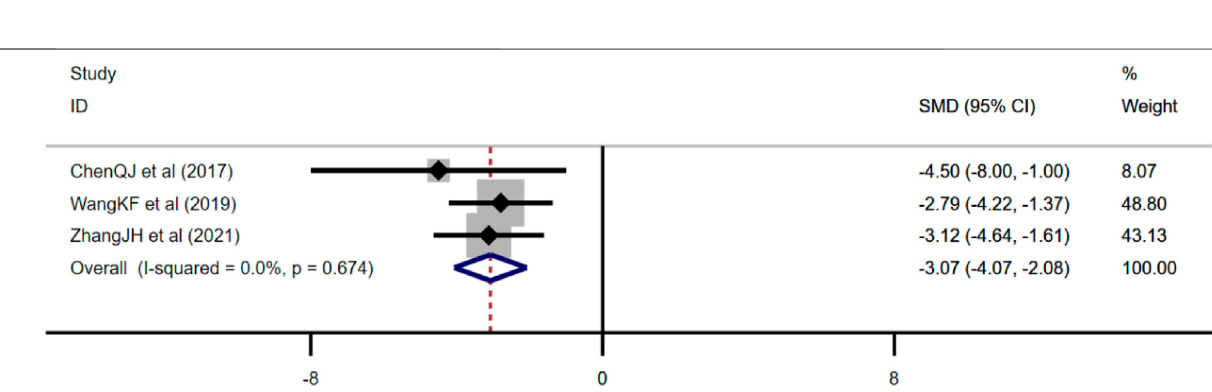
FIGURE 6 | Forest plot: effect of berberine on A β